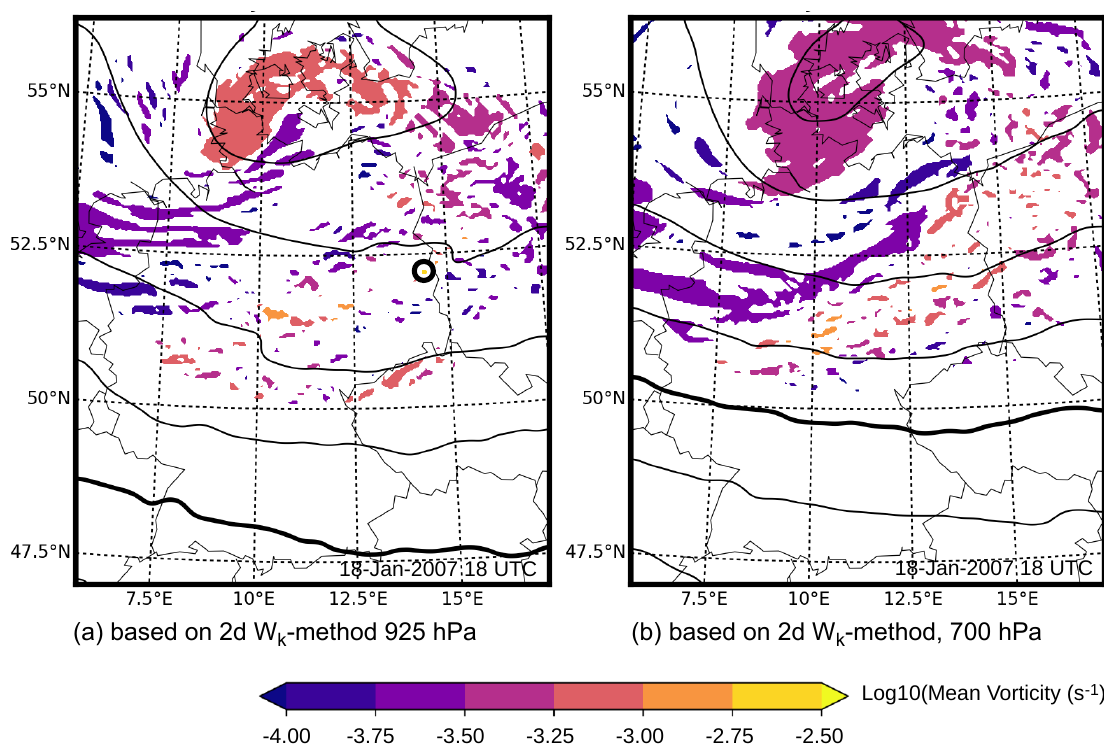
Figure 16. Vortex patches fields derived by the two-dimensional W k -method in the COSMO simulation on 18 January 2007 18:00 UTC color shaded by the logarithm of the mean vorticity (1/s) ( a ) at 925hPa and ( b ) at 700hPa. Black contours are the geopotential height in 80-m intervals; the thick black line corresponds to a geopotential height of ( a ) 680m and ( b ) 2800m; the thick black circle in ( a ) highlights the position of a bookend